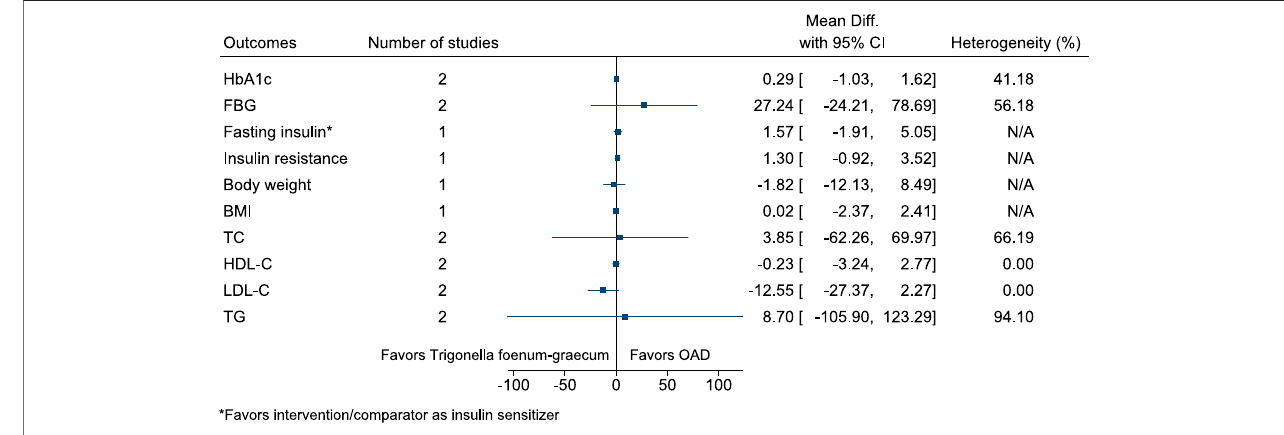
FIGURE 34 | Trigonella foenum-graecum (versus OAD) — Summary forest plot.